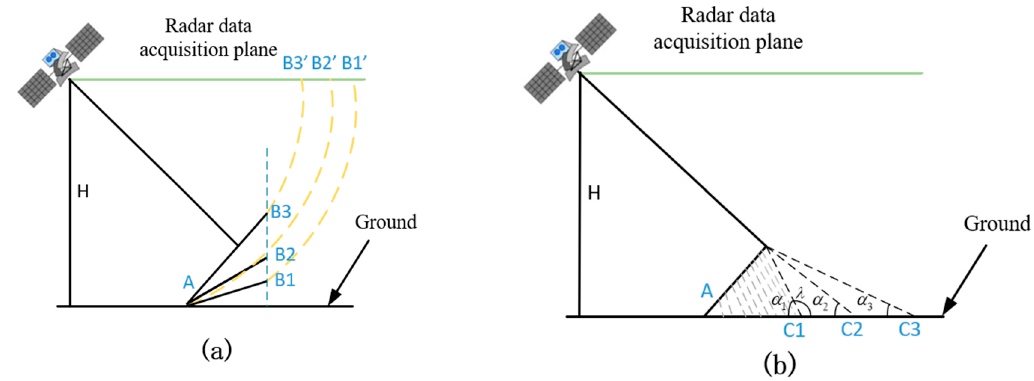
Figure 4. Geometric distortion phenomenon model: ( a ) layover. ( b ) shadow.